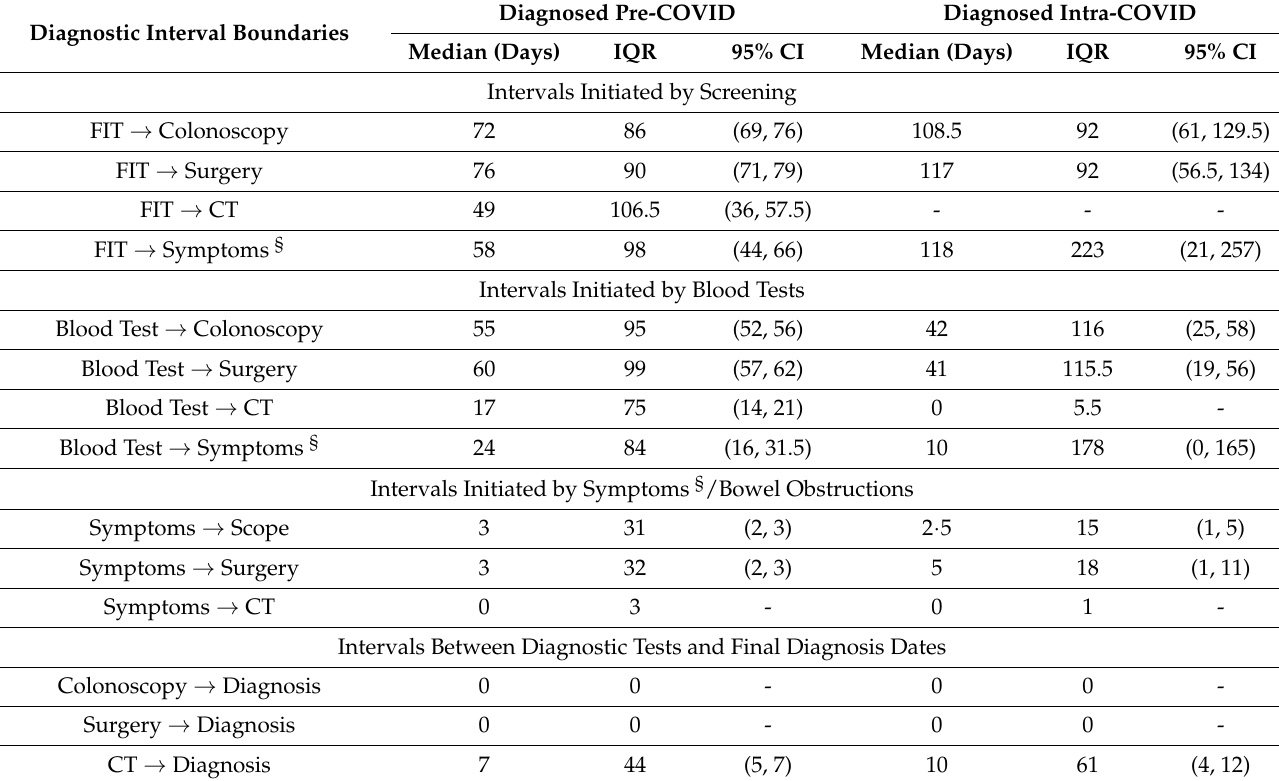
§ Symptoms and bowel obstructions are those diagnosed in an in-patient or ambulatory setting, including rectal bleeding, abdominal pain, and unexplained weight